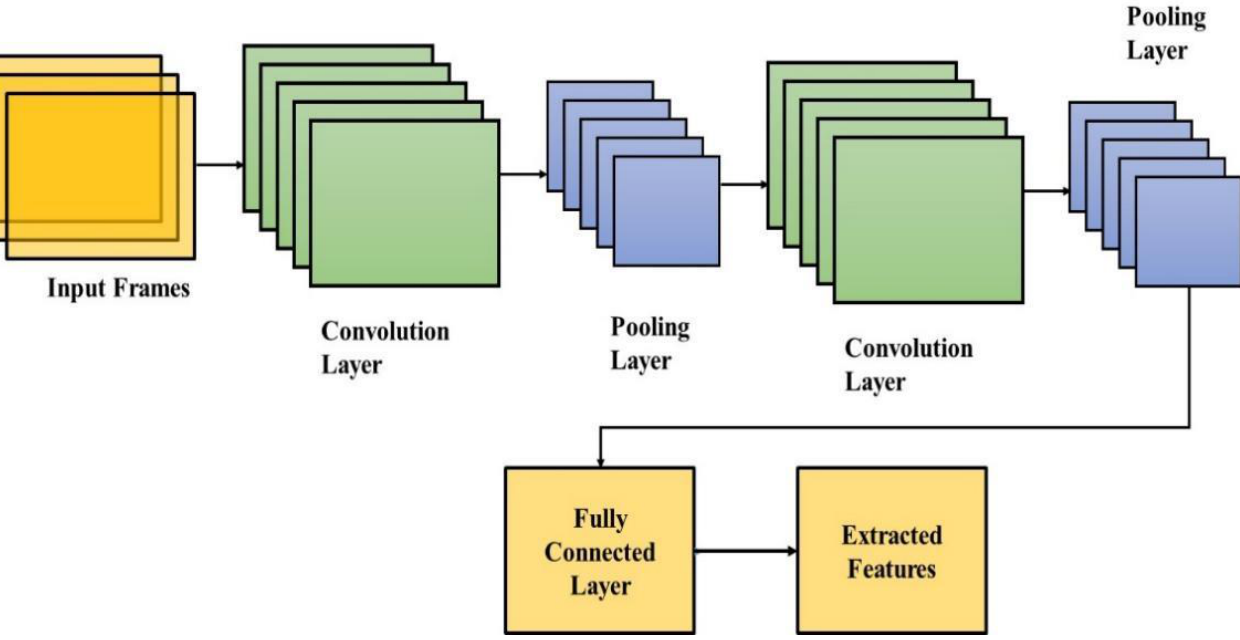
Figure 2. CNN model for feature extraction process.